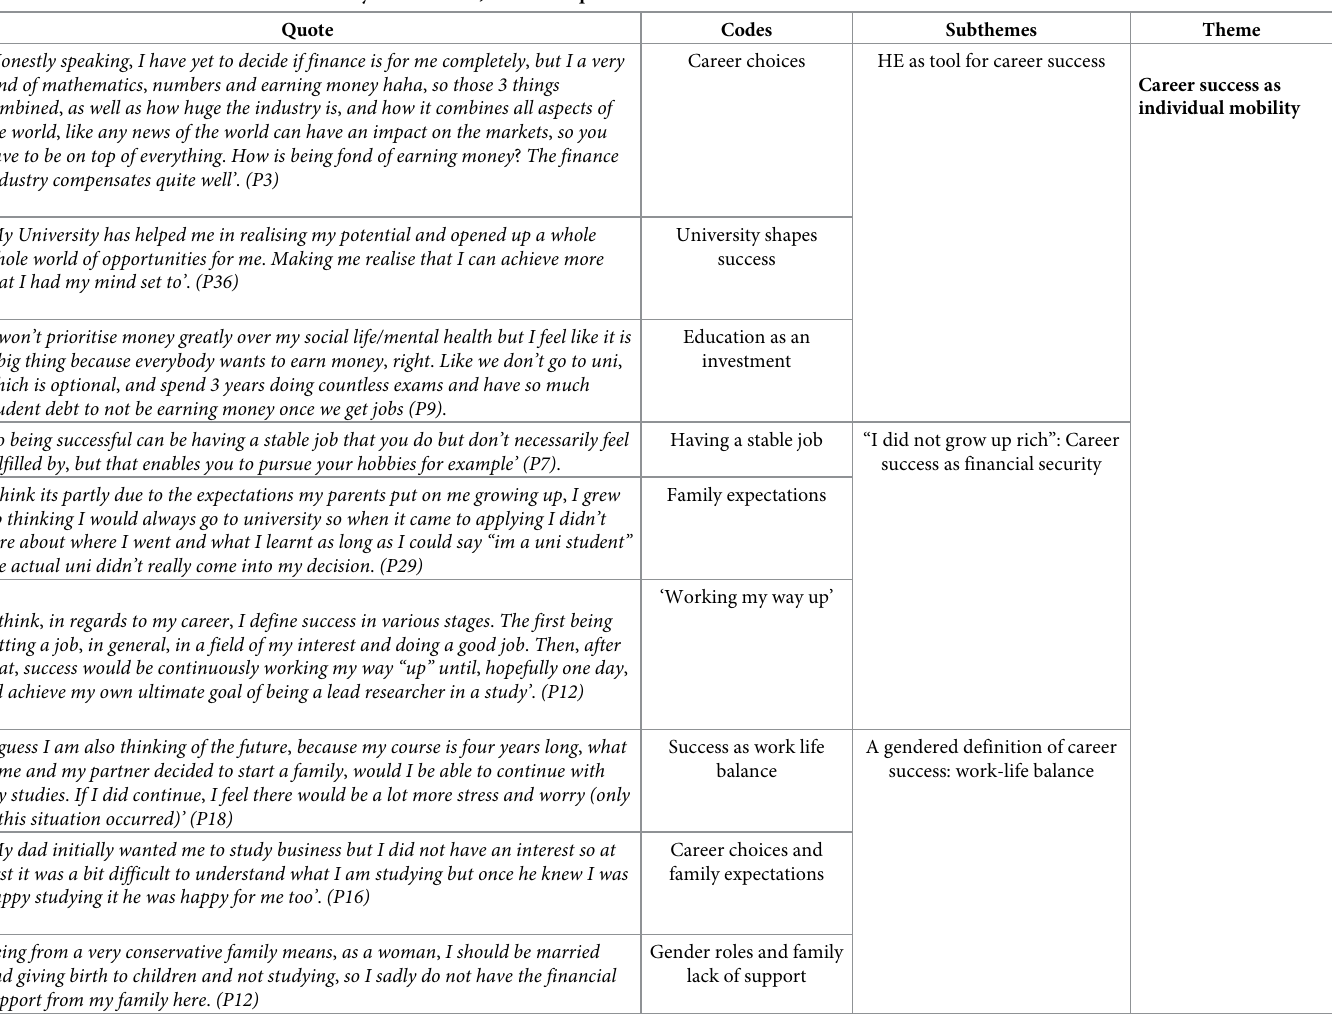
Table 3. “Career success as individual mobility”: Subthemes, codes and quotes.